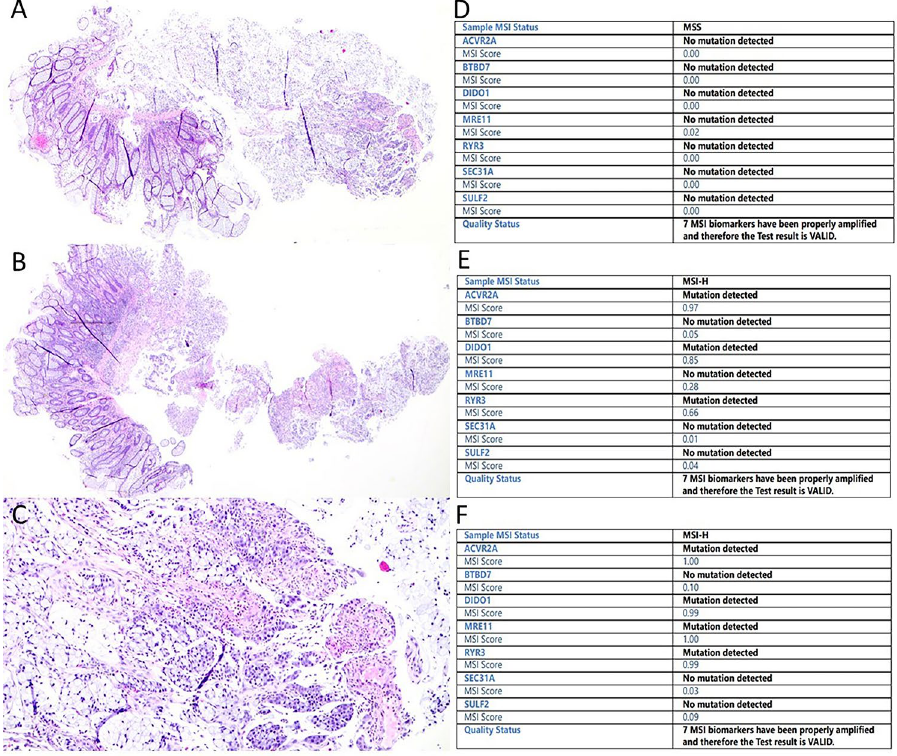
Fig. 1 Histology and Idylla MSI test reports of the signet ring cell carcinoma case (C40). (A, B) Hematoxylin-eosin staining of the two biopsies in the analyzed tissue block (original magnification x20) (C) Cancer cell area of the case C40 (original magnification x100). (D-F) Idylla MSI test report of the first analysis (two flakes, D), of the second analysis (three flakes, E), and of the surgical resection specimen (one flake,